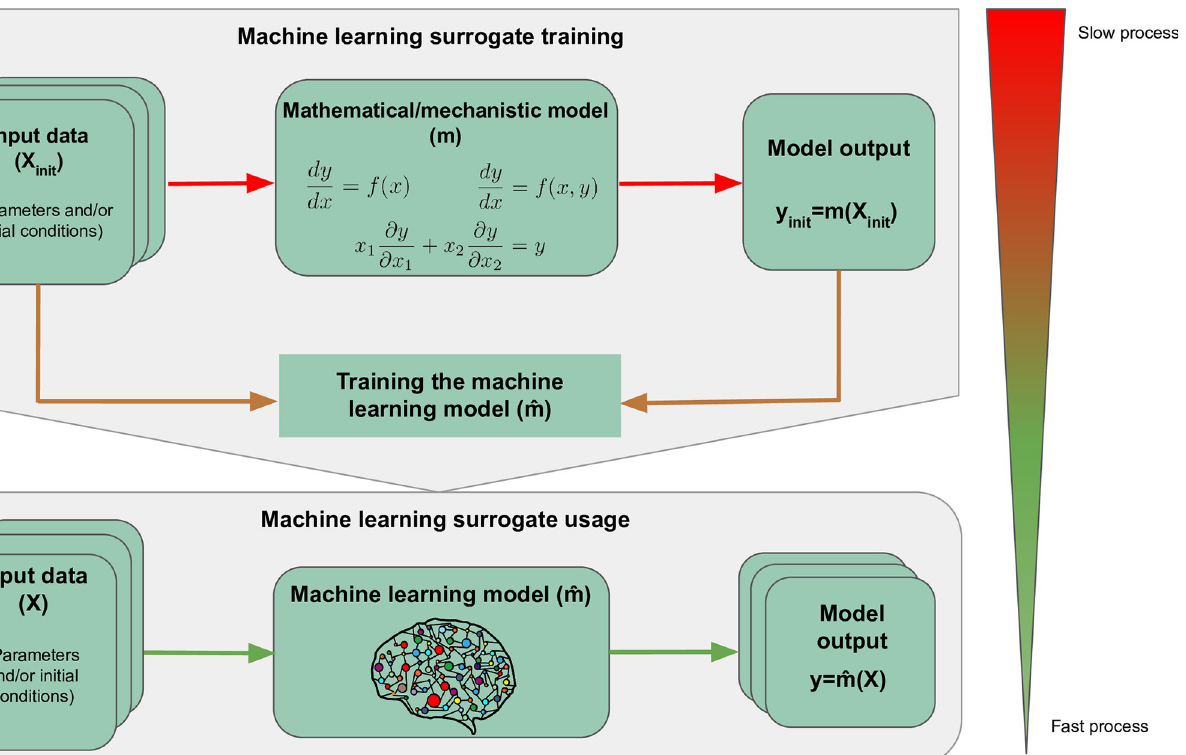
PLOS Computational Biology | https://doi.org/10.1371/journal.pcbi.1010988 April 20, 2023 2 /